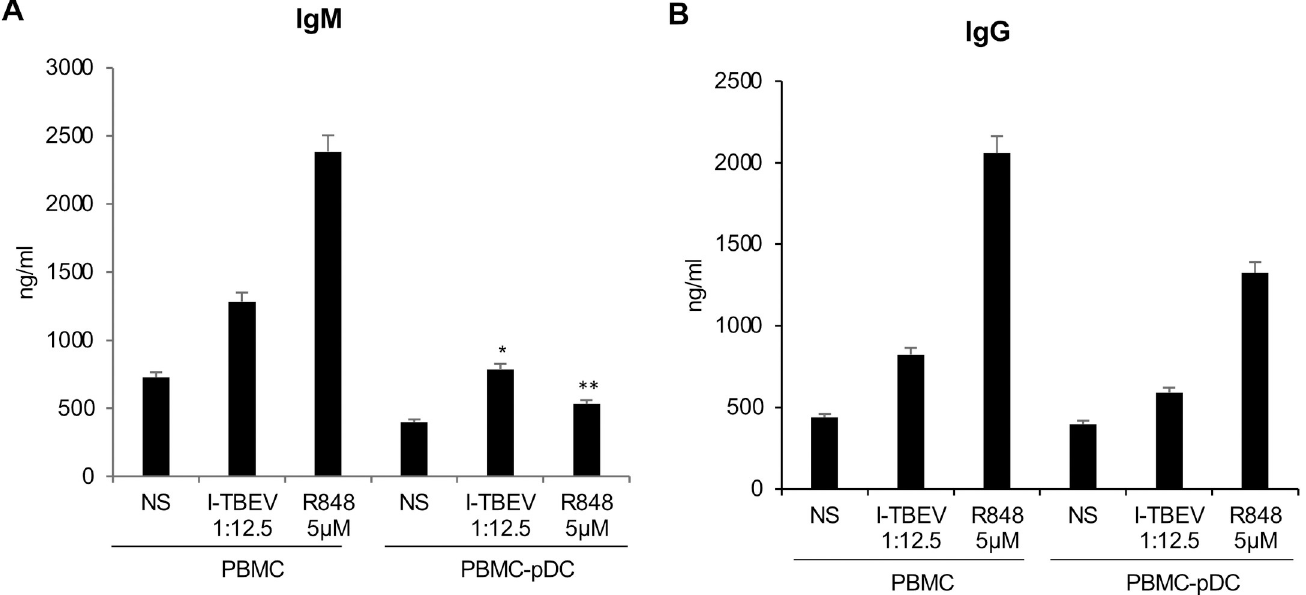
Fig 4. Ig production in PBMC or PBMC depleted of pDC after stimulation with I-TBEV. Total PBMC or PBMC depleted of pDC (PBMC-pDC) were left untreated (NS) or stimulated with R848 (5 μ M) and inactivated TBEV (I-TBEV) (dilution 1:12.5) for 10 days. The production of either total IgM (A) or IgG (B) was measured in culture supernatants by ELISA. The results shown were mean values ± SEM of 3 independent experiments. P-value for IgM: � p = 0.03; �� p = 0.02.